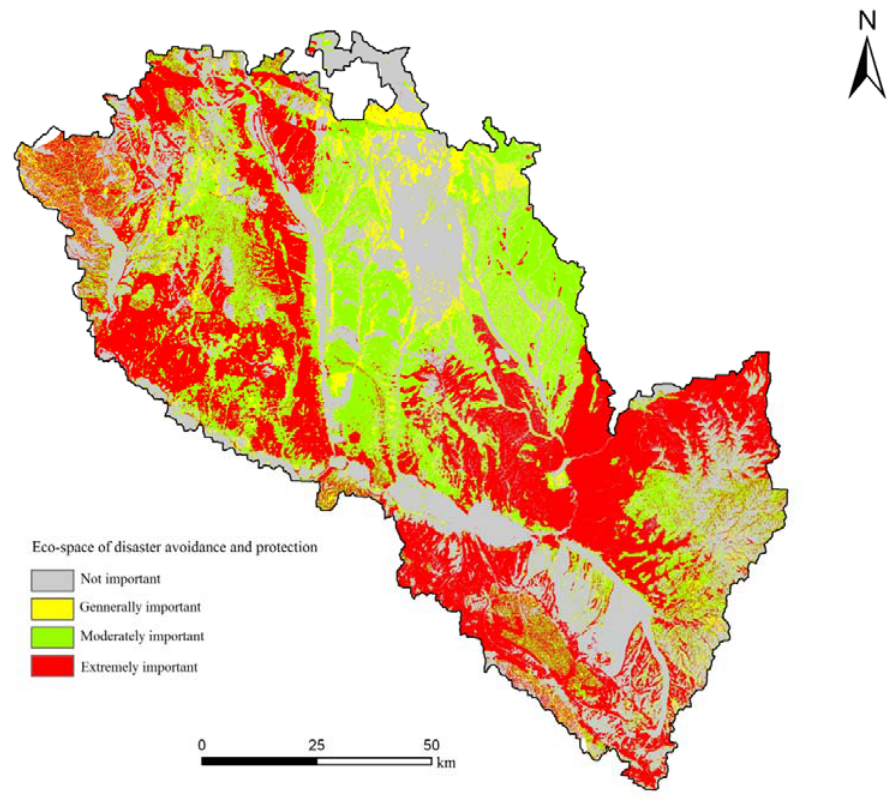
Figure 6. Evaluation results of disaster avoidance and protection importance in Lanzhou